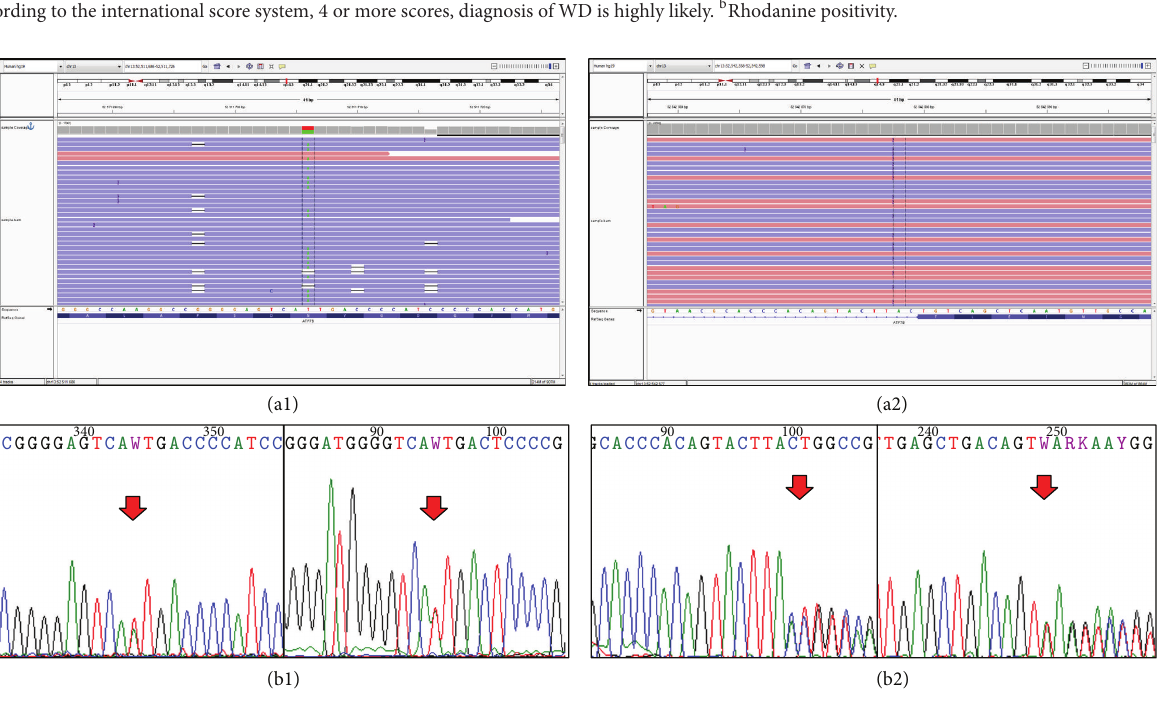
accuracy was 99.2%. The average base coverage depth